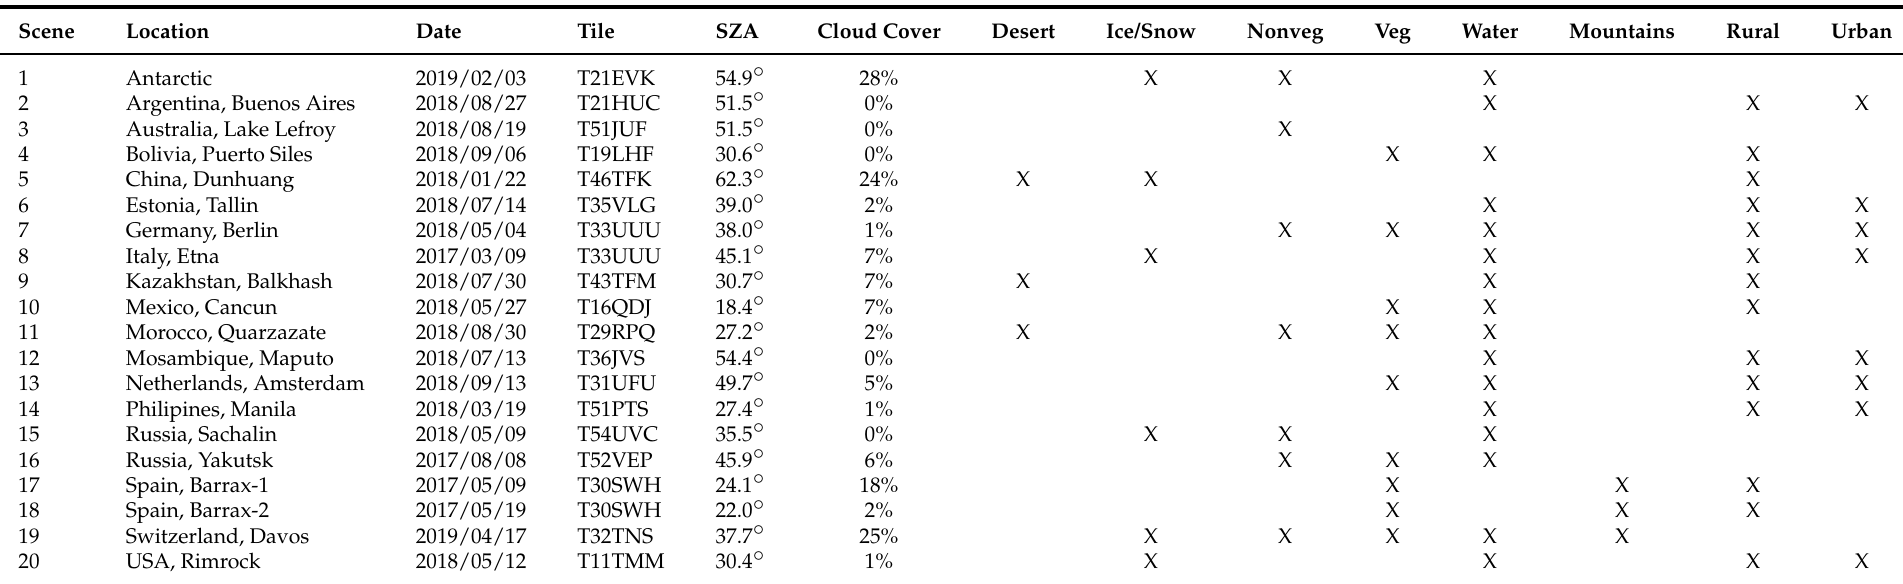
Table 2. Sentinel-2 level L1C test scenes (SZA = Solar Zenith Angle). Information on scene cloud cover, climate, main surface cover, rural/urban.